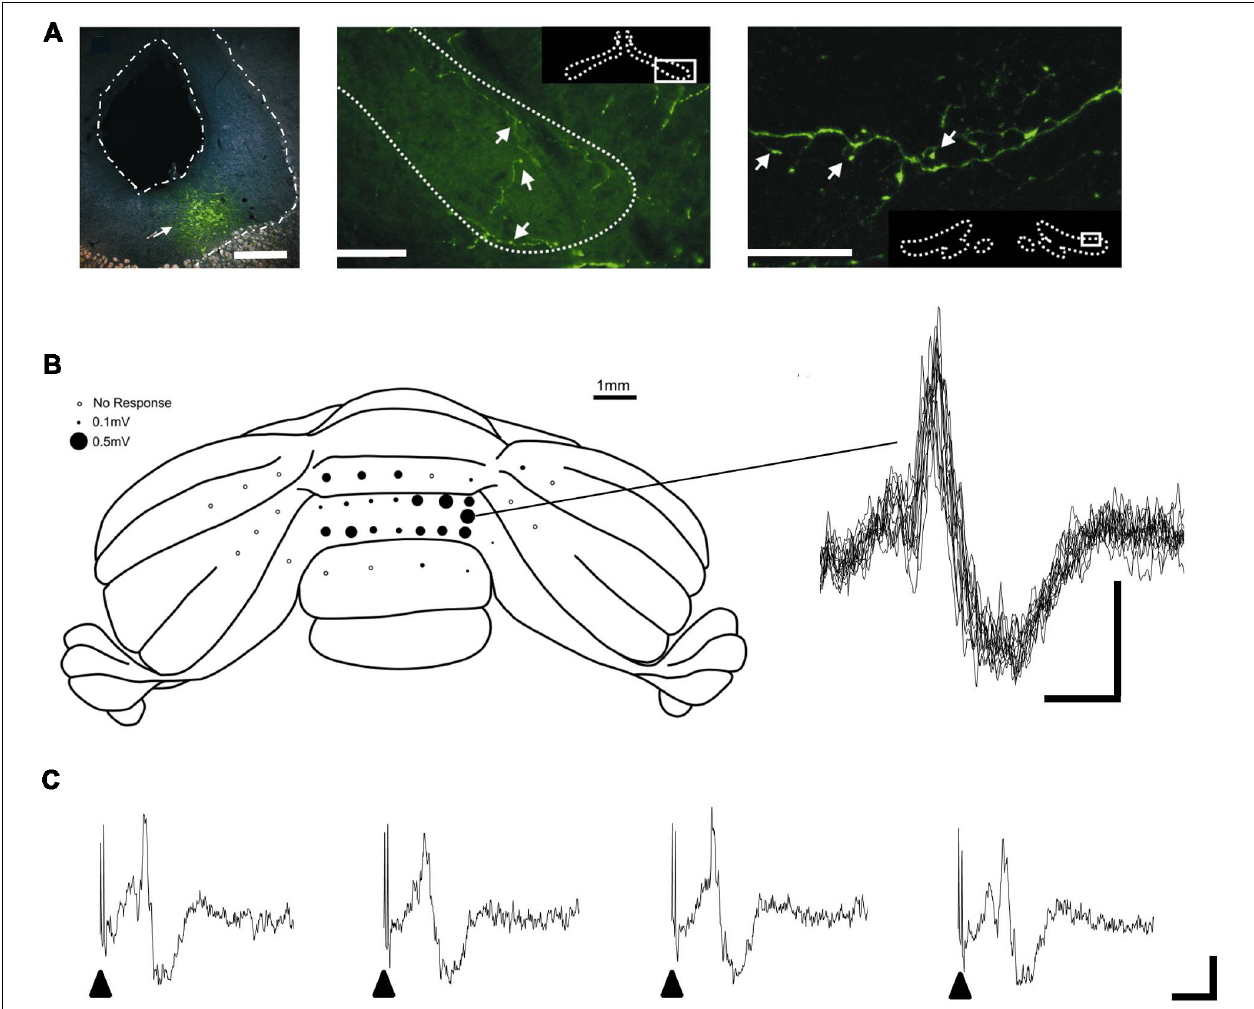
Mean peak-to-trough amplitude (three trials) is represented by the size of filled circles. Right, example waveforms (superimposition of eight consecutive responses) obtained from the recording position indicated on the cerebellar schematic. Stimulus delivered at start of each trace. Scale bar, 15 ms and 0.2 mV. (C) Example of four consecutive responses recorded from the same position on the cerebellar cortex. Filled arrow heads indicate timing of PAG stimulation. Scale bars, 20 ms and 0.2 mV. Reproduced with permission from Flavell (2008) and Crook etal.,